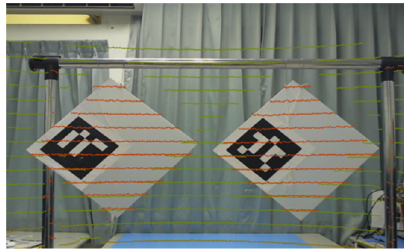
Processes 2022 , 10 , x FOR PEER REVIEW Figure 14. Projection result of using two calibration boards. Figure 14. Projection result of using two calibration boards. Figure 14. Projection result of using two calibration boards.